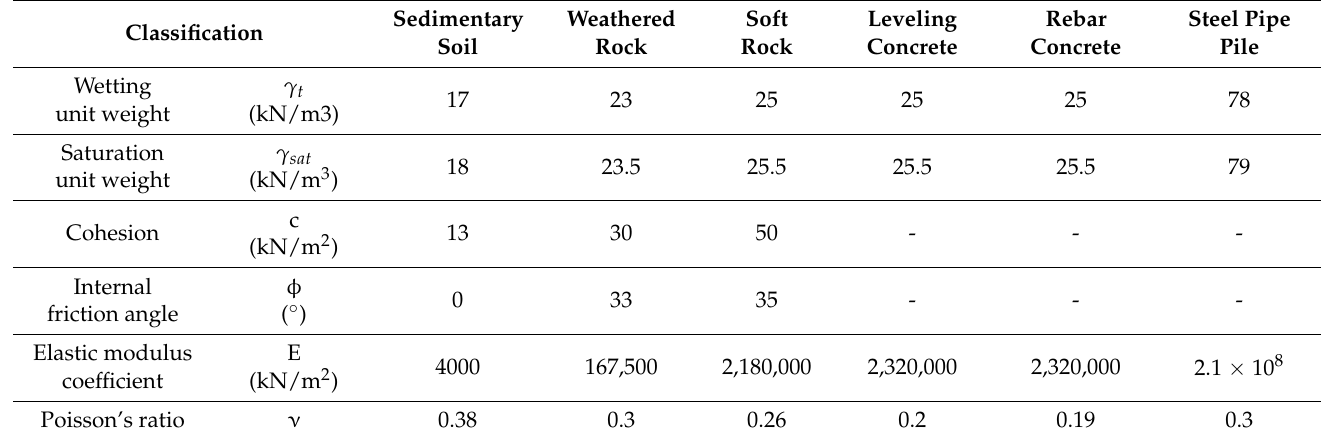
Table 9. Material properties applied to the numerical analysis.